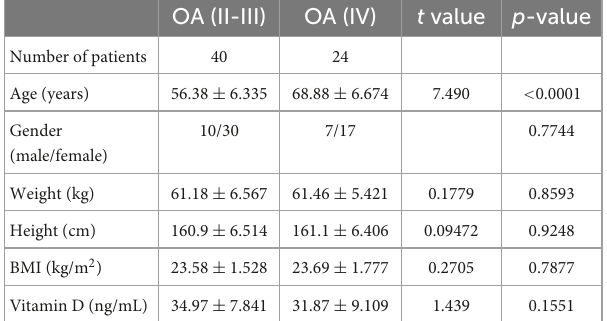
TABLE 1 Demographic data of all patients.